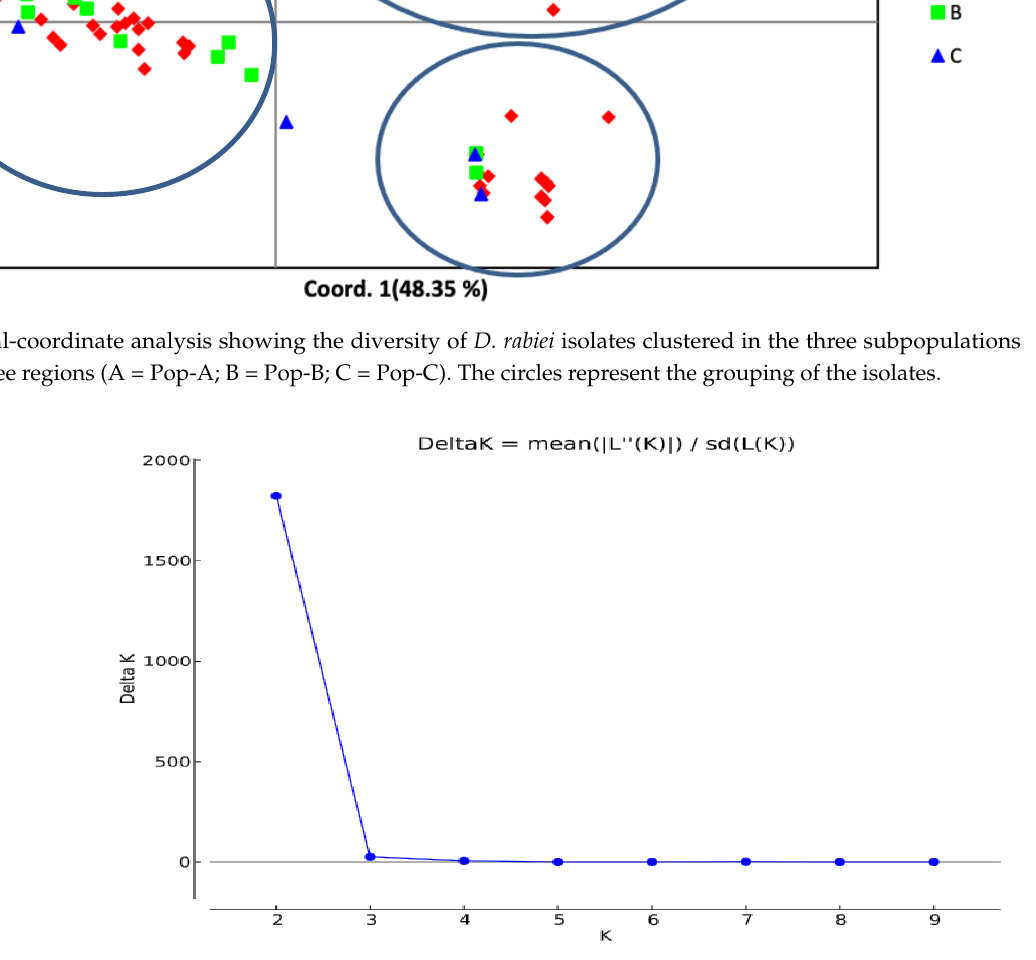
Figure 4. Log probability of the data (LnP(D)) for structure estimation of the number of subgroups from K -values ranging from 1 to 10 by ΔK values (gray line = initial modal value).